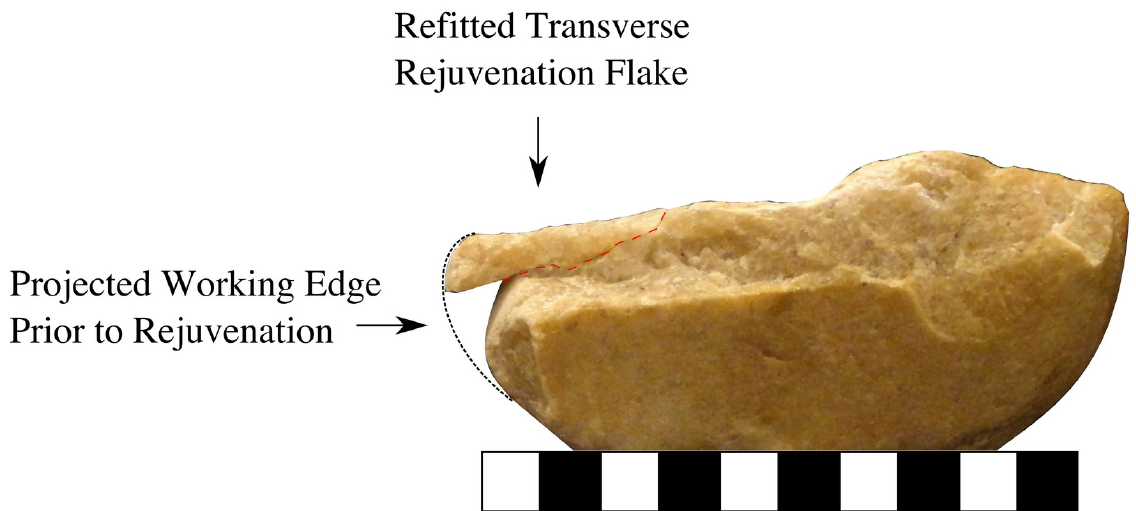
Figure 3. A flaked cobble tool depicted with the distal end of a refitted rejuvenation flake (red dotted-line). Upon refitting, the plunged lateral margin of the rejuvenation flake provides a projection of the use-edge prior to rejuvenation (black dotted-line). Scale bar = 10